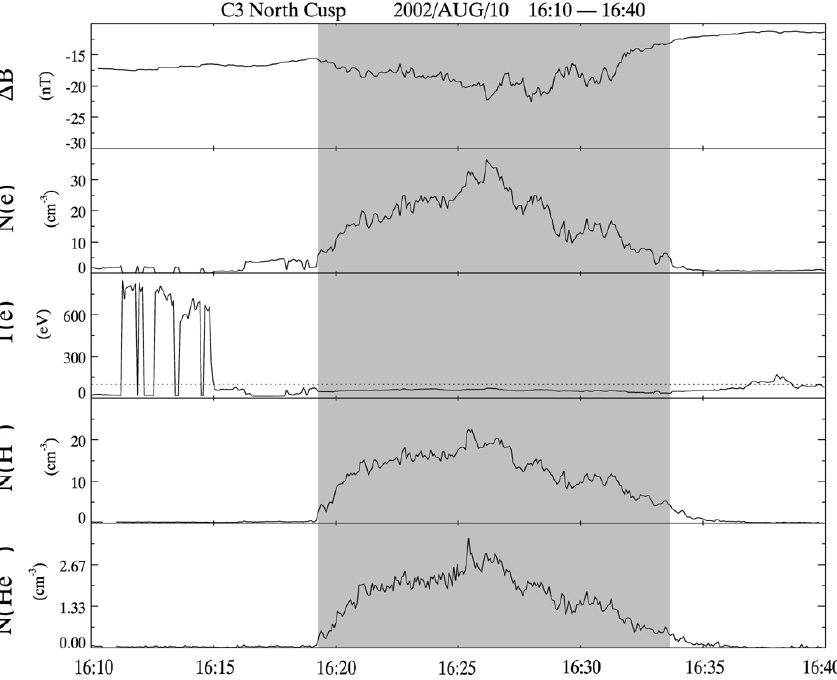
Fig. 1. Example of cusp crossings of Cluster on 10 August 2002: from the upper to bottom panel show the residual of the magnitude of Cluster FGM data with the T96 model, the PEACE electron density and energy, the HIA H + density, and the He ++ density, respectively. The shadow indicates the polar cusp region based on the